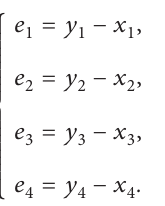
− x − x ; (b) x 1 3 2 4